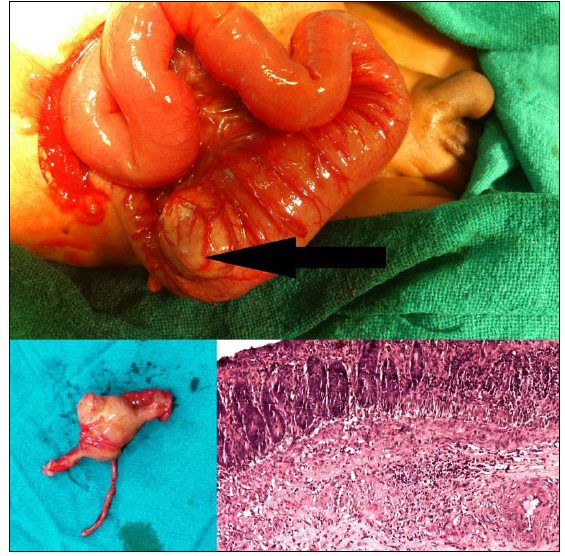
Figure 1: (Upper) Peroperative photograph showing an intraluminal cystic lesion at ileocecal region with dilated small intestine proximal to the lesion. (Lower-right) Photograph showing resected cystic lesion with dilated proximal fragment and narrowed distal fragment. (Lower-left) Photomicrograph showing the lining of cystic lesion (Hematoxylin & eosin stain, ×